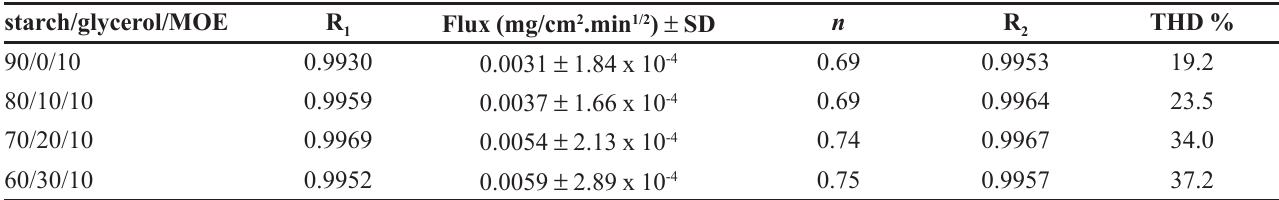
TABLE II - Flux from equation 5, results of calculated number n from equation 6, correlation coefficient for equation 5 (R equation 6 (R ), and total hydroxycinnamic derivatives released from the films (%). 2